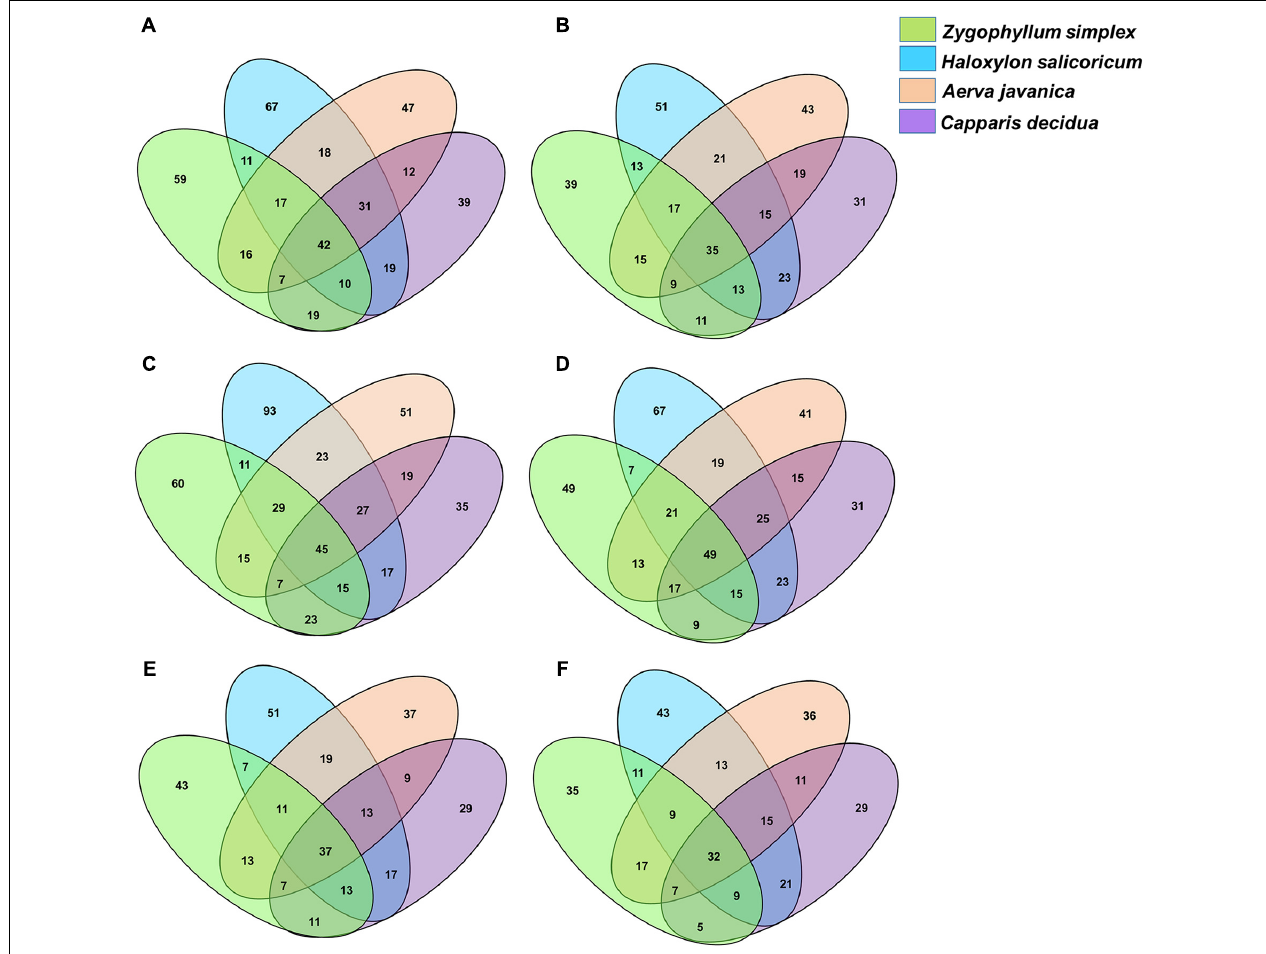
FIGURE 5 | Venn diagram showing the numbers of bacterial genera identified from the rhizosphere and the root endosphere of desert halophytes. (A,B) Samples collected from the site 1, (C,D) Samples collected from the site 2, and (E,F) Samples collected from the site 3.